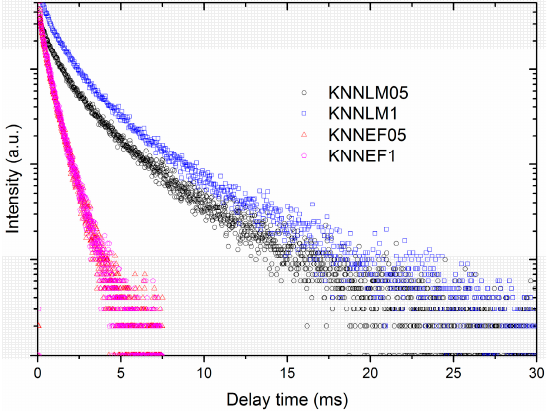
Figure 6. Luminescence decay curves of red emission for La–Mn and Eu–Fe co-doped KNN ceramics.